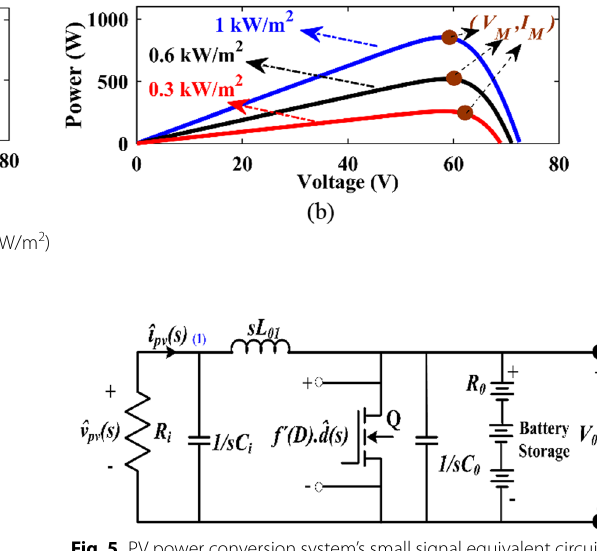
Fig. 5 PV power conversion system’s small signal equivalent circuit